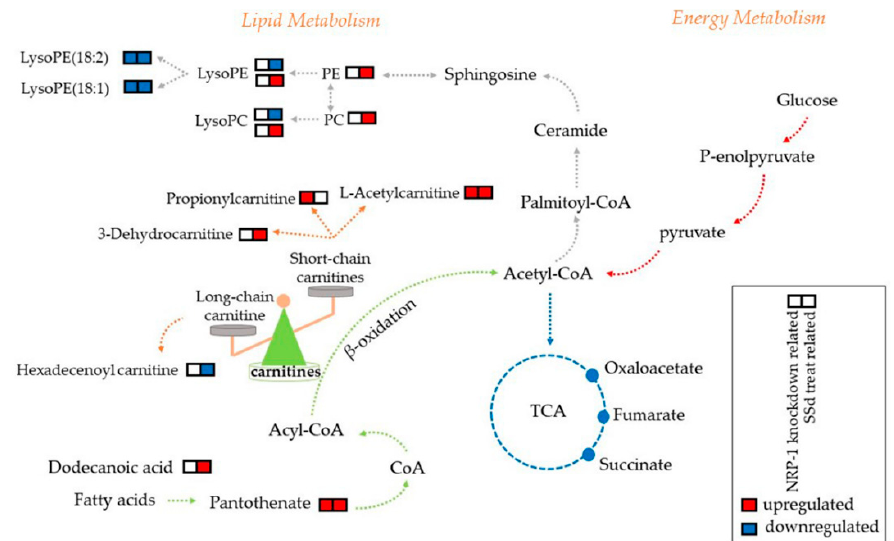
Figure 5. The possible perturbed metabolic pathways in response to NRP-1 knockdown and/or SSd. Upregulated (red) and downregulated (blue) levels of metabolites observed are indicated.